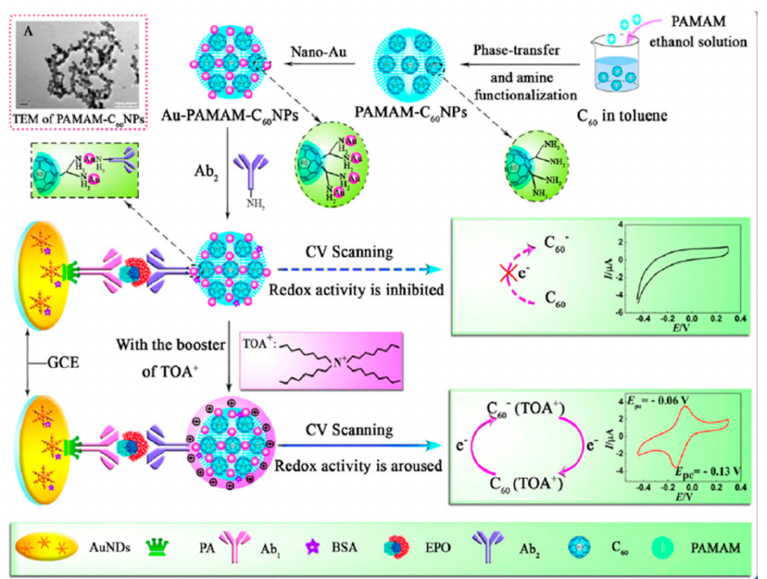
Figure 9. Schematic representation of the preparation of AuNPs/PAMAM/C 60 nanocomposite used as an immunosensor for EPO detection. Reprinted from [80], copyright 2015,